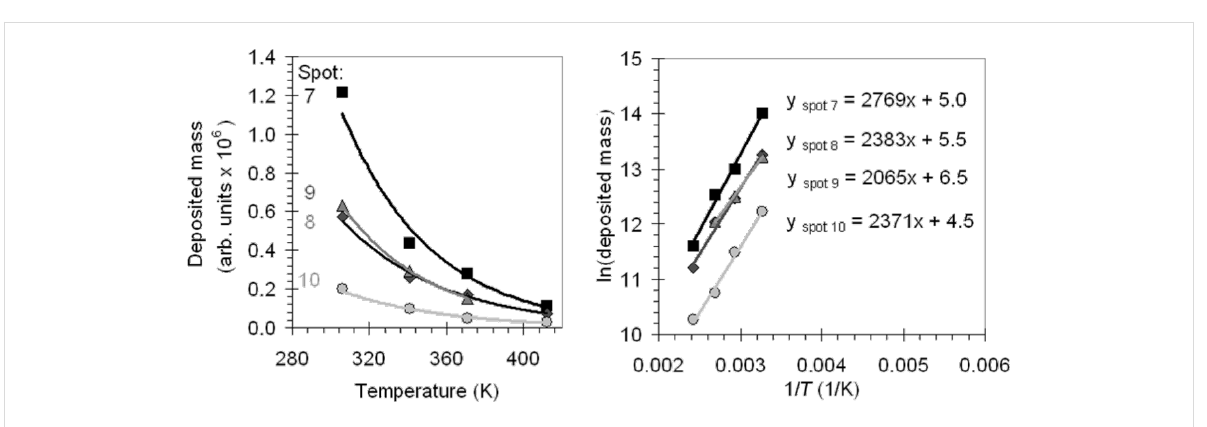
Figure 2: (a) The average deposited mass per dot as a function of substrate temperature and beam current. (b) The Arrhenius plot for the four beam currents, constructed from the data in (a).